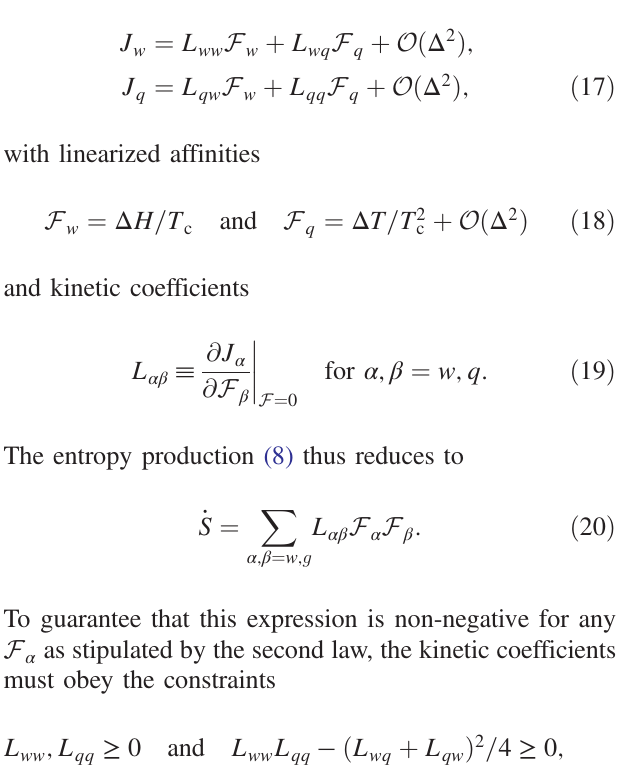
FIG. 1. Nonequilibrium periodic state of a system with 1 degree of freedom x in a sinusoidally shifted harmonic potential, represented by gray parabolas, which is embedded in an environment with periodically changing temperature as indicated by the periodic color gradient. The solid line in the x - t plane shows the motion of the center of the Gaussian phase-space distribution, which lags behind the position of the potential minimum shown as a dashed line. At any time t , the width of the colored region equals the width of the phase-space distribution, which varies according to the